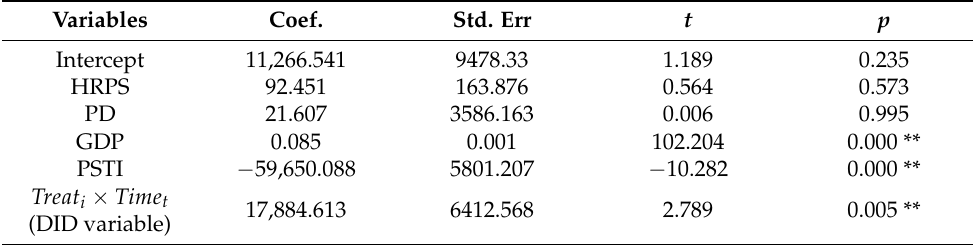
Table 2. Estimation results of the fixed effects DID model. Variables